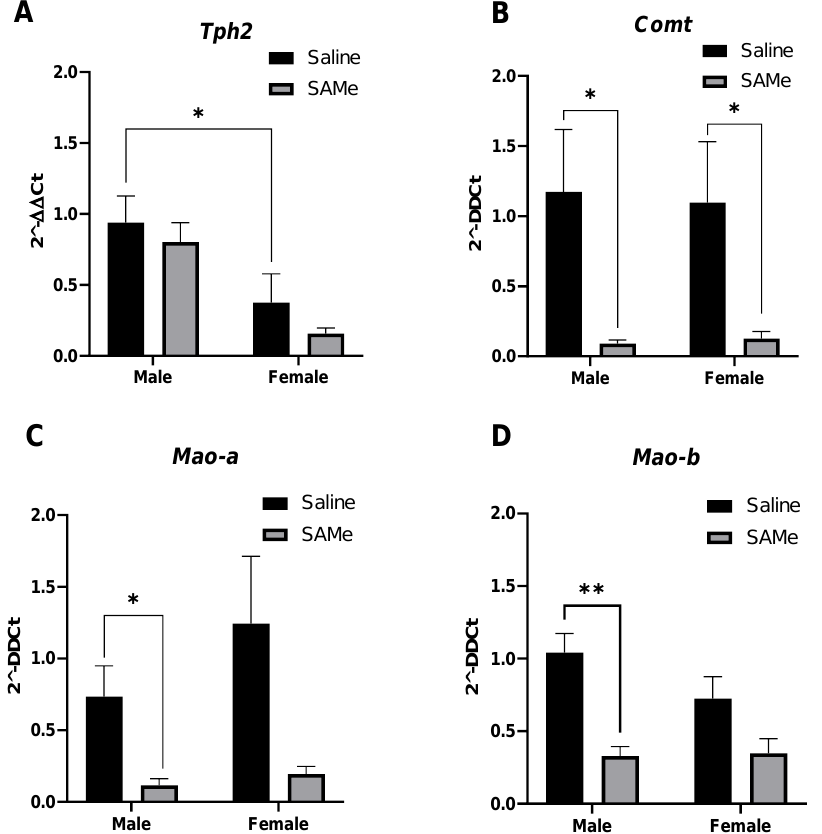
Figure 3. Tph2, Mao-a , Mao-b and Comt genes expression in the PFC. SAMe treatment significantly decreased the expression of Mao-a ( C ) and Mao-b ( D ) genes only in male Sub mice and decreased the level of Comt ( B ) in both genders. No effect of SAMe treatment was measured on Tph2 ( A ) gene expression in either males or females. The data are presented as means ± SEM, * p < 0.05 or ** p <